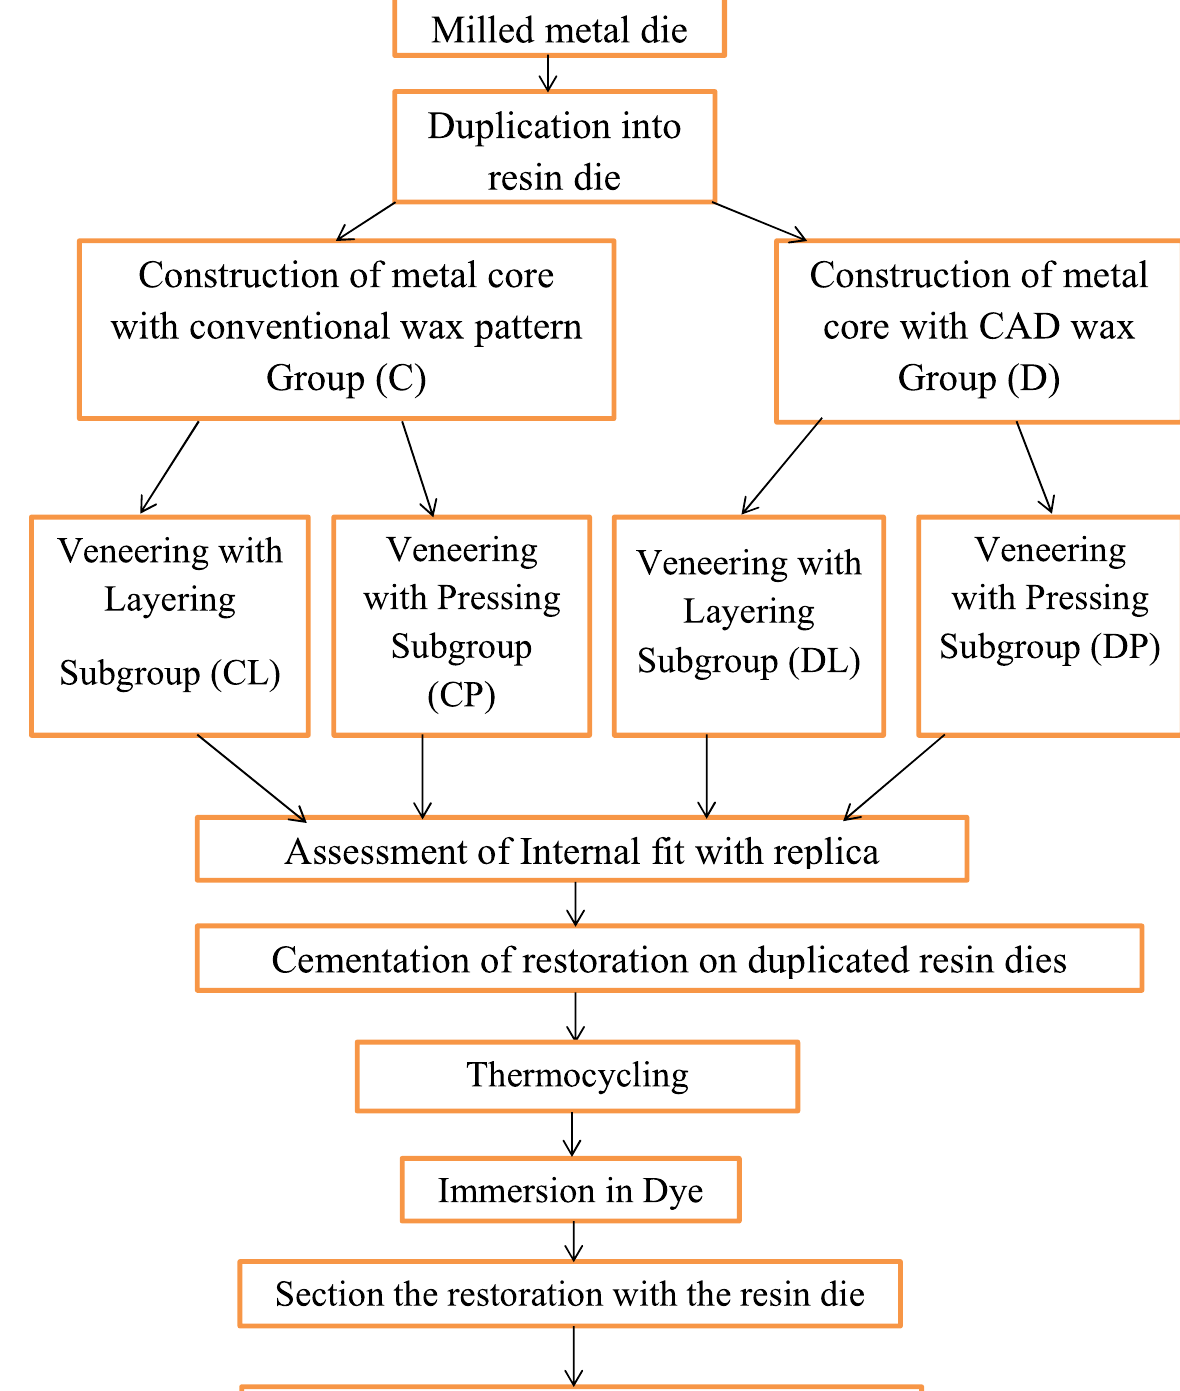
Fig. 1 Study design. Schematic diagram illustrating brie fl y in-vitro to unavoidable inaccuracies. 2,8,9 Wax – up quality is dependent on the skill of the operator. CAD/CAM enhanced the accuracy of standardized restorations and reduced errors, time, labor and production cost. However, CAD systems also have some disadvantages. Limitation of fi nite resolution in light laser scanner can make sharp edges slightly rounded. 1,2